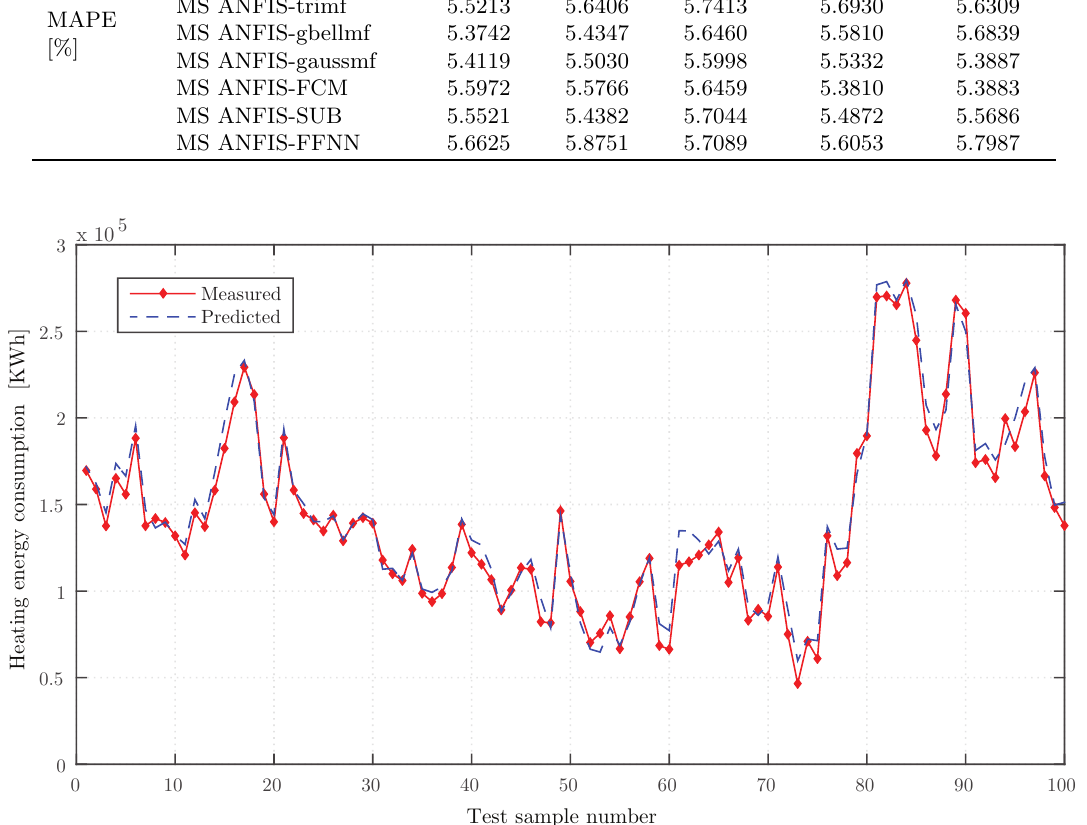
Figure 13: Prediction results of multistage ensemble ANFIS FCM with 5 clusters for testing period